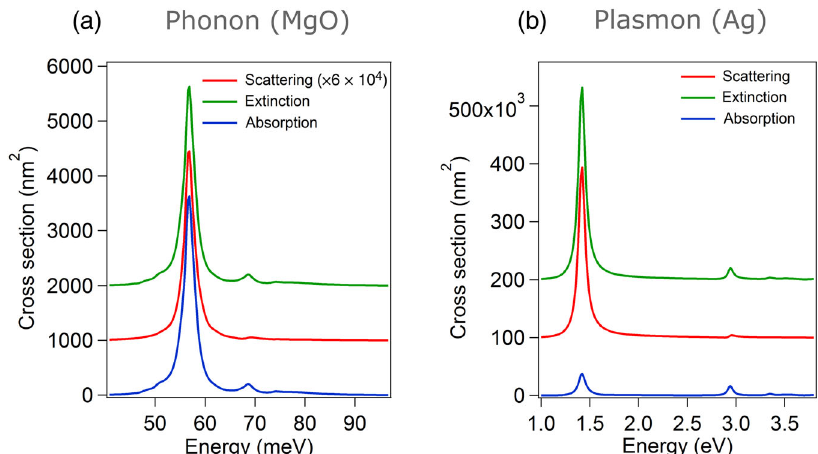
FIG. 3. Optical extinction, absorption, and scattering cross sections for (a) A MgO nanoantenna and (b) a silver nanoantenna. Both antennas have the same size ( 200 × 30 nm). Note the absolute cross section